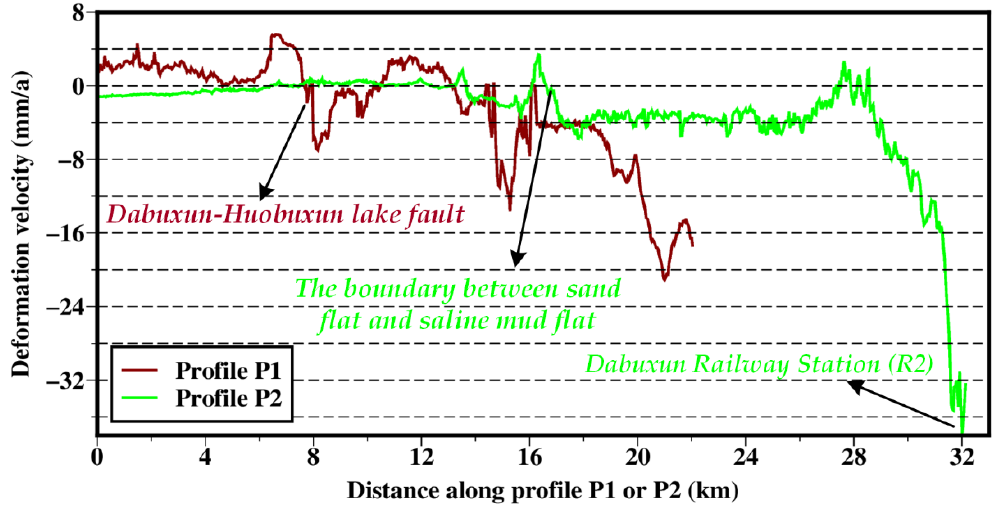
Figure 13. The profiles of the deformation velocity in area (a) and area (b), the dark red line indicates the profile P1 in area (a) and the green line indicates the profile P2 in area (b).